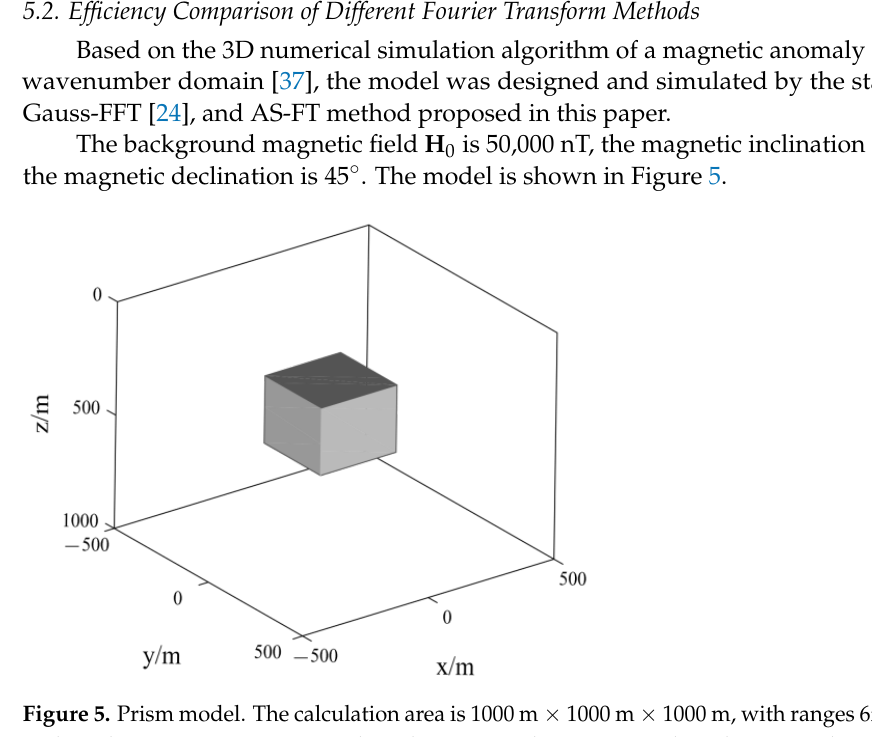
Figure 5. Prism model. The calculation area is 1000 m × 1000 m × 1000 m, with ranges 6f − 500–500 m in the x direction, − 500–500 m in the y direction, and 0–1000 m in the z direction. The prism anomaly is a cube with a side length of 400 m, and the prism’s center coincides with the model’s center. The magnetic susceptibility of the prism is 0.01